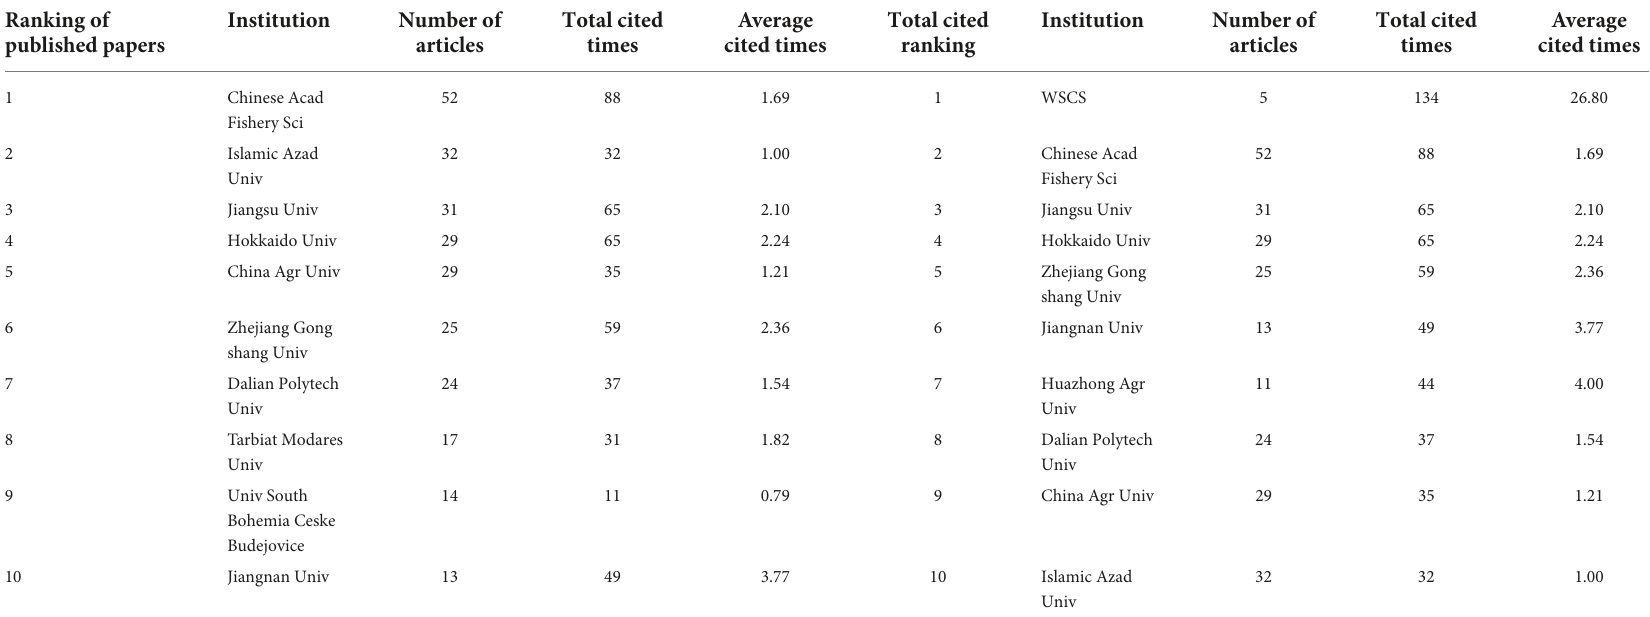
TABLE 1 Major research institutions in the field of sturgeon deep processing in the world from 2010 to